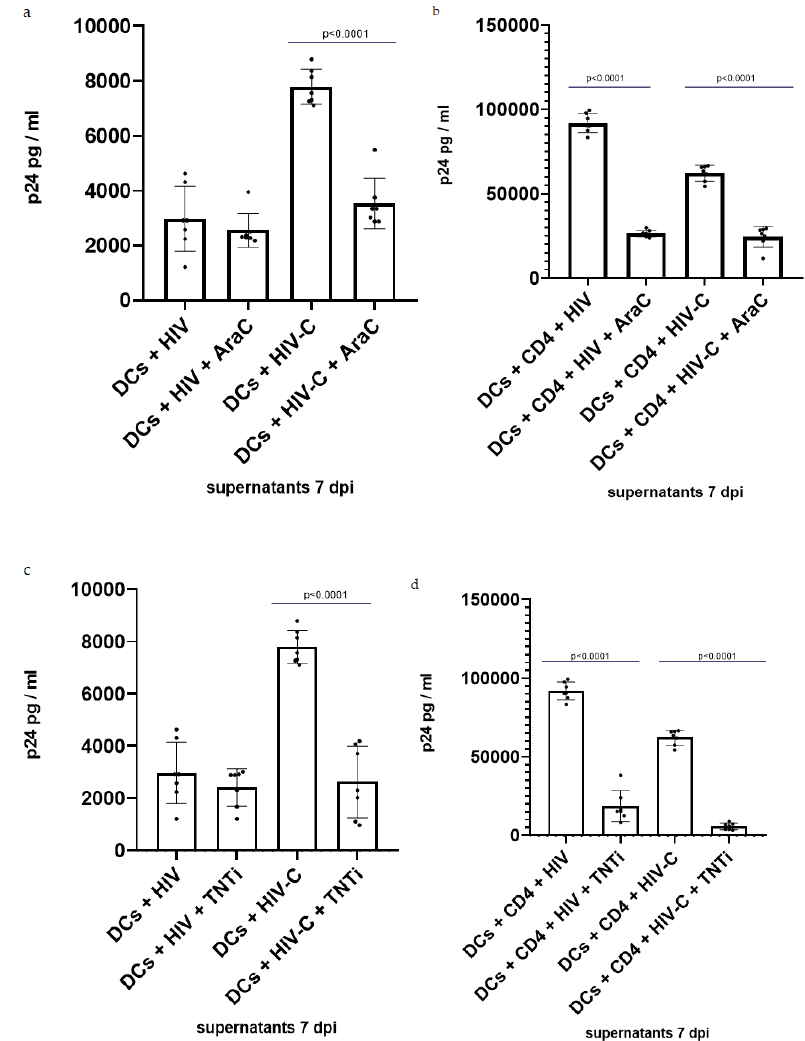
Figure 3. TNT inhibition decreases infection in HIV-C-loaded DCs and in DC/CD4 + T-cell co-culture independently of virus opsonization pattern. ( a ) Quantification of infection in 7 dpi supernatants from HIV/HIV-C-infected DCs with/without 24 h treatment with 1 µ M AraC. HIV-C-infected DCs treated with AraC show significantly decreased, moderate productive infection compared to their untreated counterparts ( p < 0.0001). Experiments were performed for a minimum of 3 independent replicates, and statistical significance was analyzed using GraphPad Prism software v9 [60] and ordinary one-way ANOVA. ( b ) Quantification of infection in 7 dpi supernatants from HIV/HIV-C-infected DC/CD4 + T-cell co-cultures with/without 24 h treatment with 1 µ M AraC. The inhibition of infection is observed to be independent of HIV opsonization ( p < 0.0001). Experiments were performed for a minimum of 3 independent replicates, and statistical significance was analyzed using GraphPad Prism software v9 [60] and ordinary one-way ANOVA. ( c ) Quantification of infection in 7 dpi supernatants from HIV/HIV-C-infected DCs with/without 24 h treatment with 20 µ M TNTi. HIV-C-infected DCs treated with TNTi show significantly decreased, moderate productive infection compared to their non-treated counterparts ( p < 0.0001). Experiments were performed for a minimum of 3 independent replicates, and statistical significance was analyzed using GraphPad Prism software v9 [60] and ordinary one-way ANOVA. ( d ) Quantification of infection in 7 dpi supernatants from HIV/HIV-C-infected DC/CD4 + T-cell co-cultures with/without 24 h treatment with 20 µ M TNTi. The inhibition of infection is observed to be independent of HIV opsonization ( p < 0.0001; p < 0.001). Experiments were performed for a minimum of 3 independent replicates, and statistical significance was analyzed using GraphPad Prism software v9 [60] and ordinary one-way